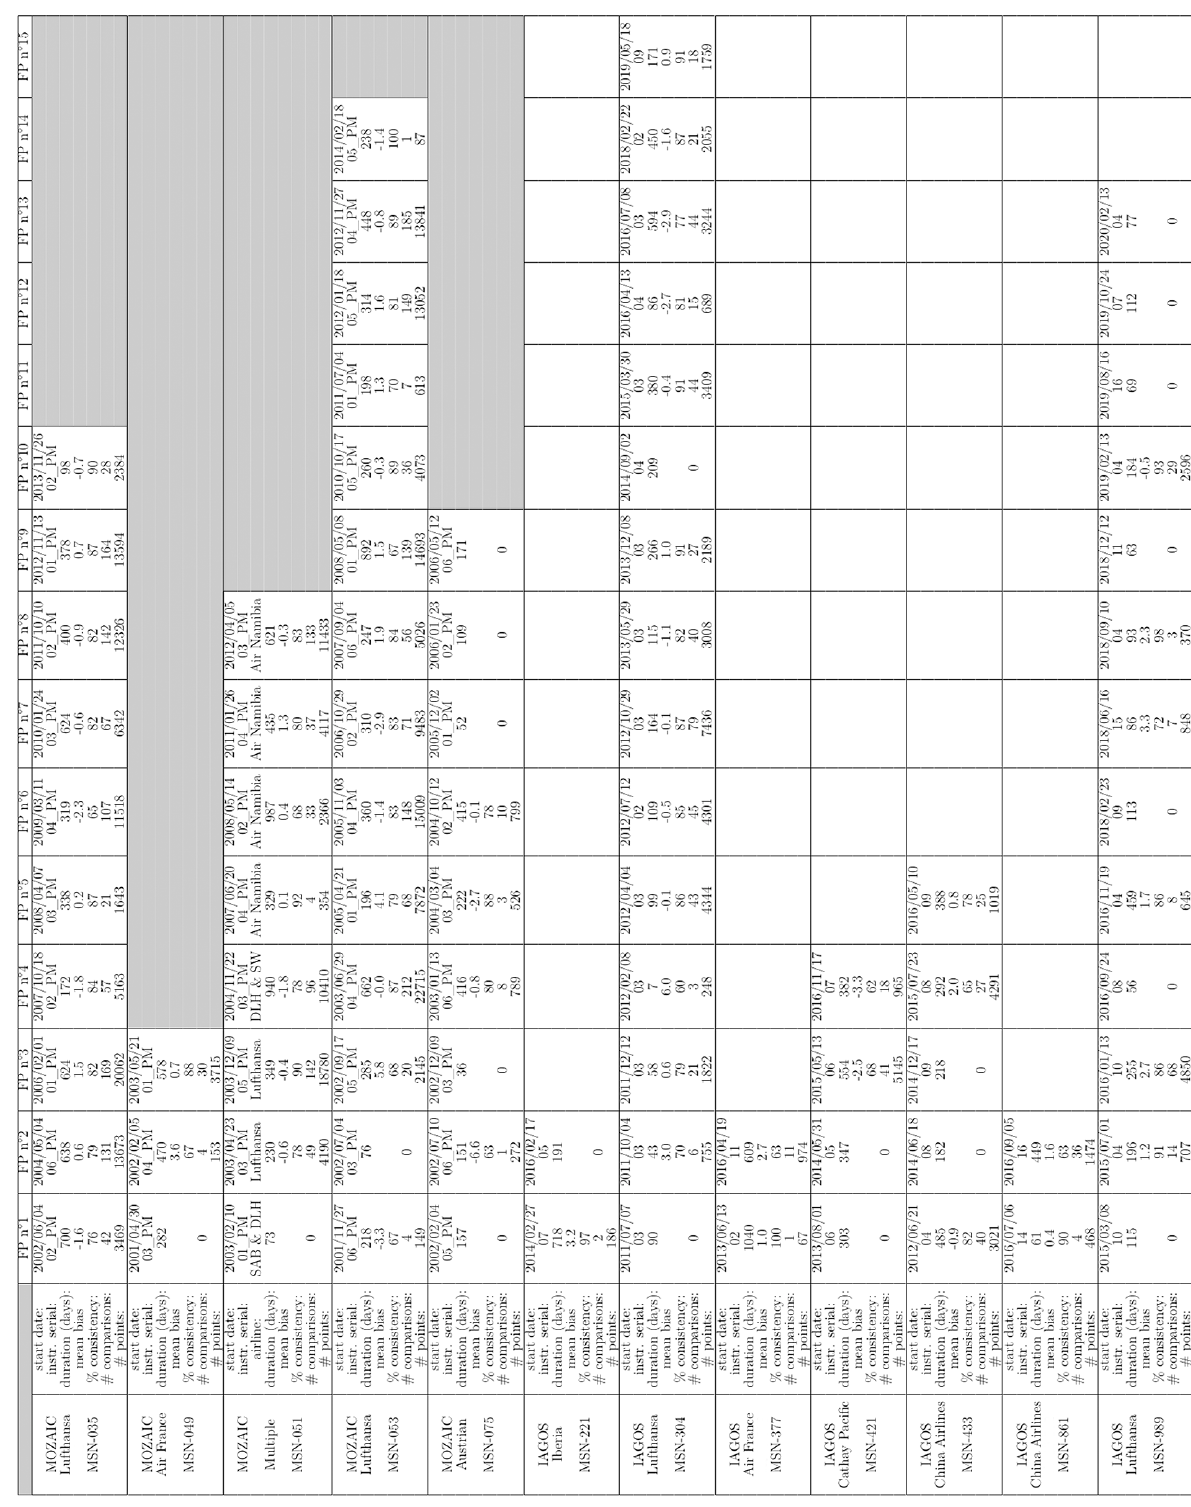
Table 5. Same as Table 4 but for